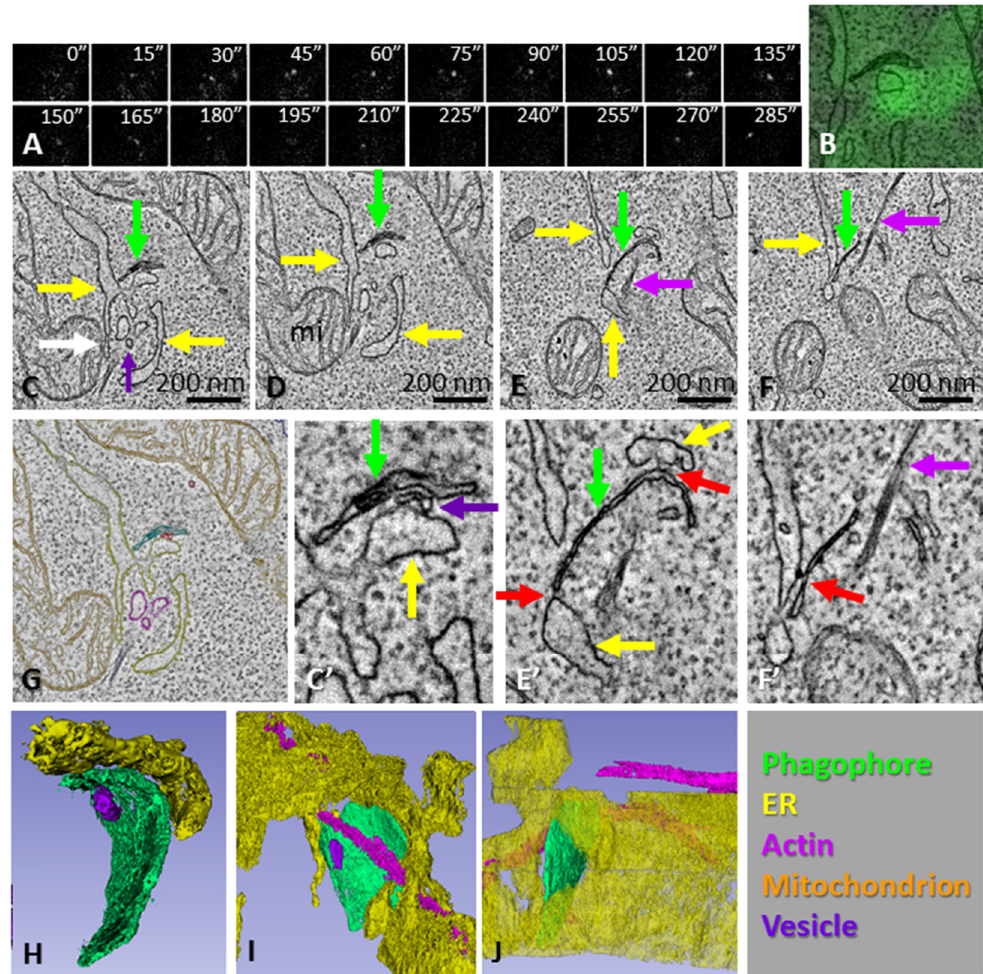
Figure 5. CLEM of a phagophore. ( A ) HEK293 cells expressing GFP-tagged ATG13 were time-lapse imaged to trace ATG13 puncta. The cells were fixed 4 min 45 s after the appearance of the ATG13 punctum. After fixation, the same cell and punctum were imaged with electron tomography. ( B ) One slice of the tomogram overlaid with the ATG13 fluorescence. ( C – F ) Tomography slices showing the phagophore (green arrows), ER (yellow arrows), vesicles (purple arrows) and a bundle of putative actin filaments (pink arrows). The white arrow in panel ( C ) indicates an MCS between a mitochondrion (mi) and ER close to the phagophore. ( G ) Organelles in the tomogram were traced with different colors, as indicated by the overlay, as well as the bottom right panel of the figure. Panels ( C’ , E’ , F’ ) show enlarged details from panels ( C , E , F ), respectively. The red arrows in panels ( E’ , F’ ) indicate MCSs between the phagophore and ER. ( H – J ) Views of the 3D model from different angles, demonstrating the close apposition of the phagophore, ER and vesicles, as well as the location of the actin filament bundle. See also Supplementary Figure